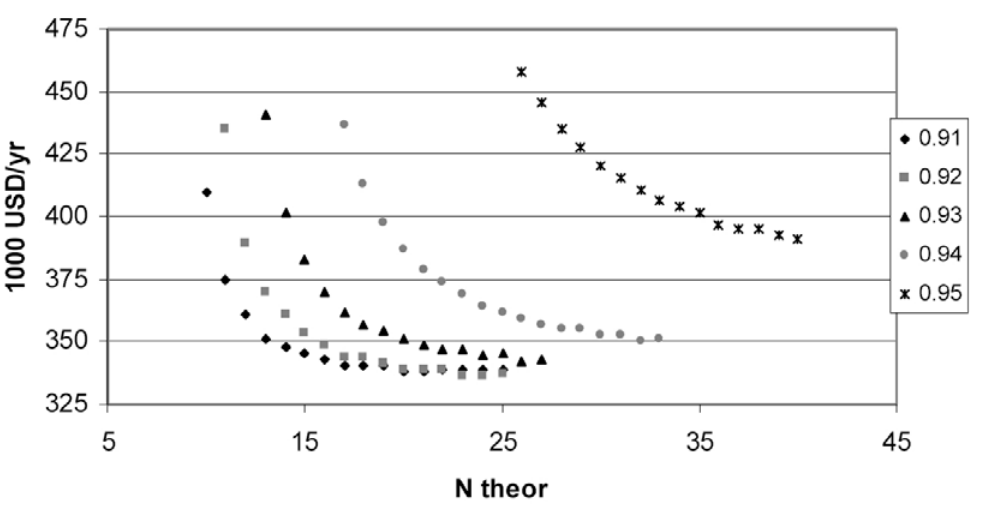
Fig. 11 Total annual cost of D+PV system.